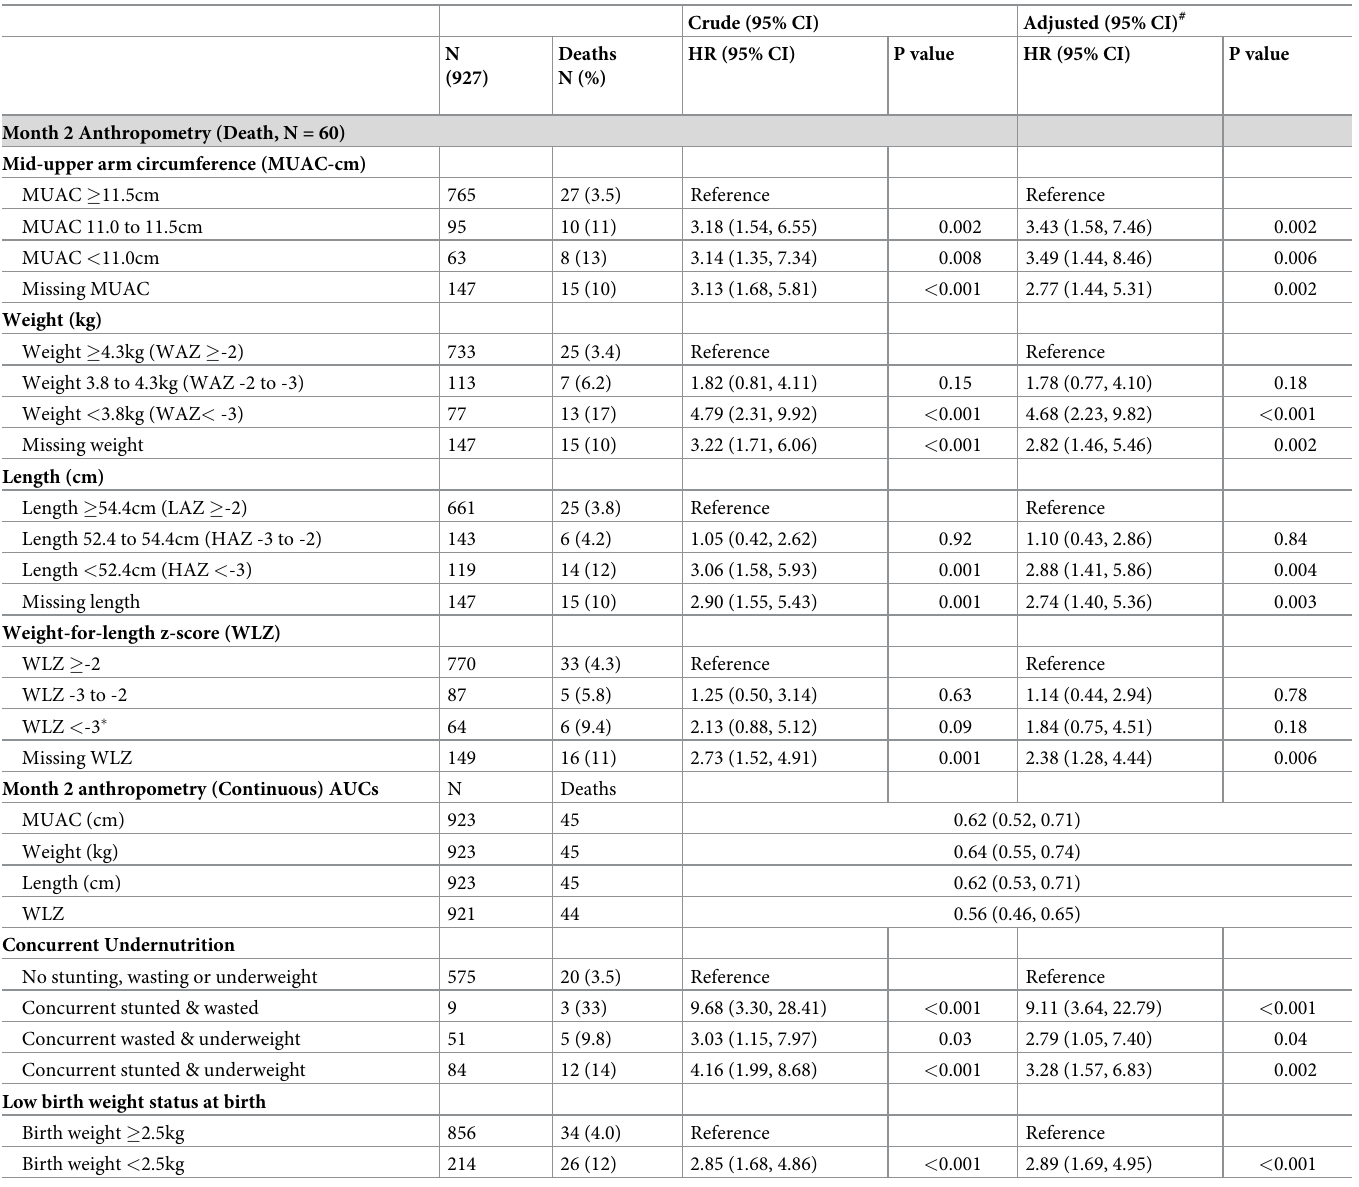
Table 3. Month two anthropometry and mortality to 12 months of